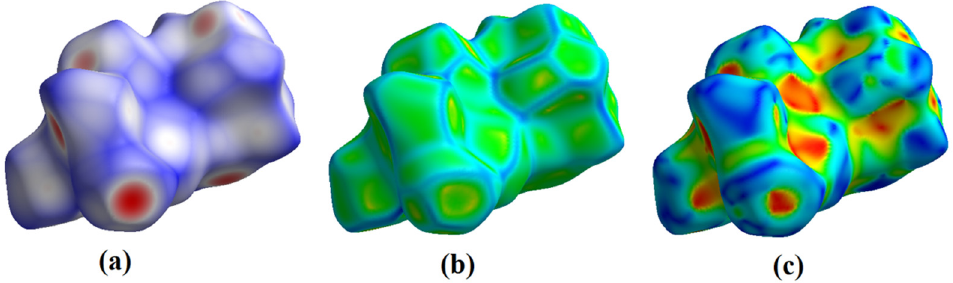
Figure 5. HS mapped over d norm ( a ), curvedness ( b ), and shape index ( c ) surfaces.